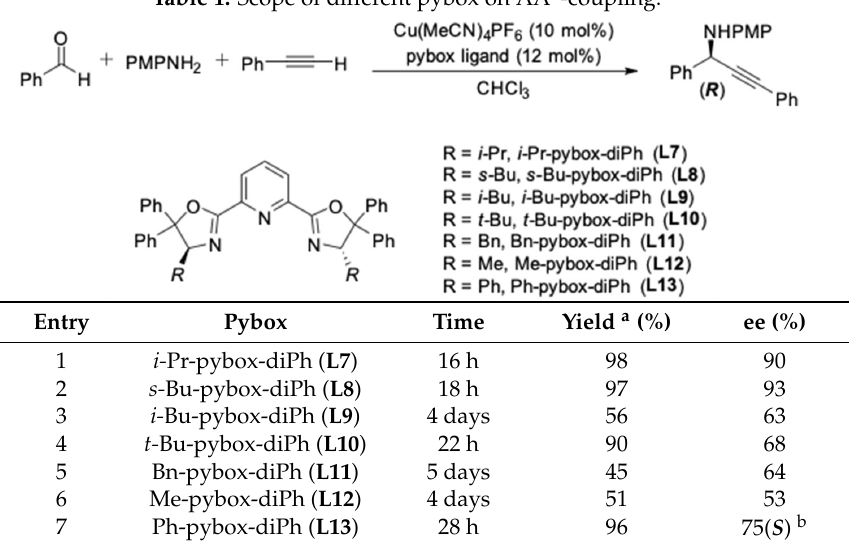
Table 1. Scope of different pybox on AA 3 -coupling.